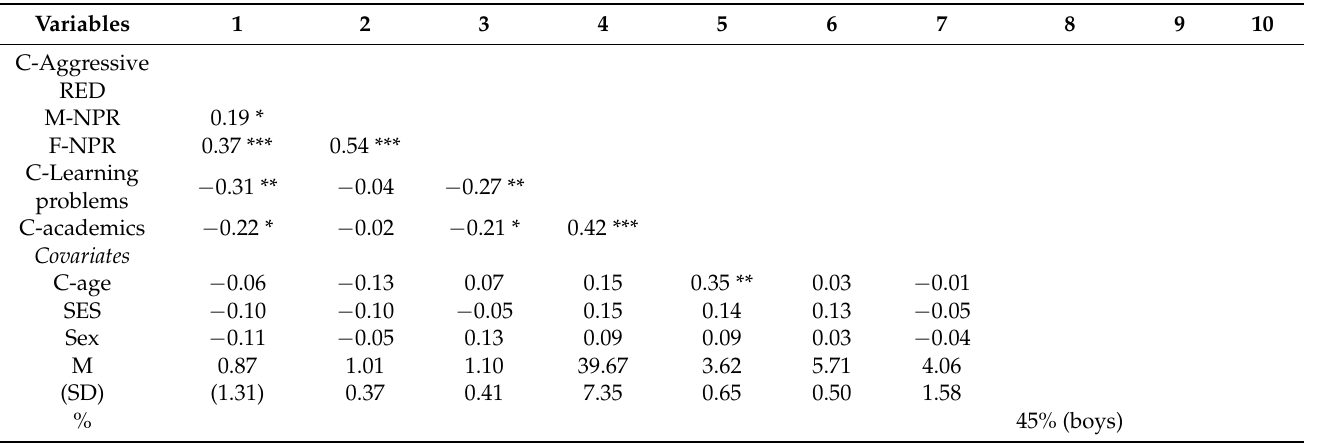
Table 1. Correlation matrix and means (SD) for study